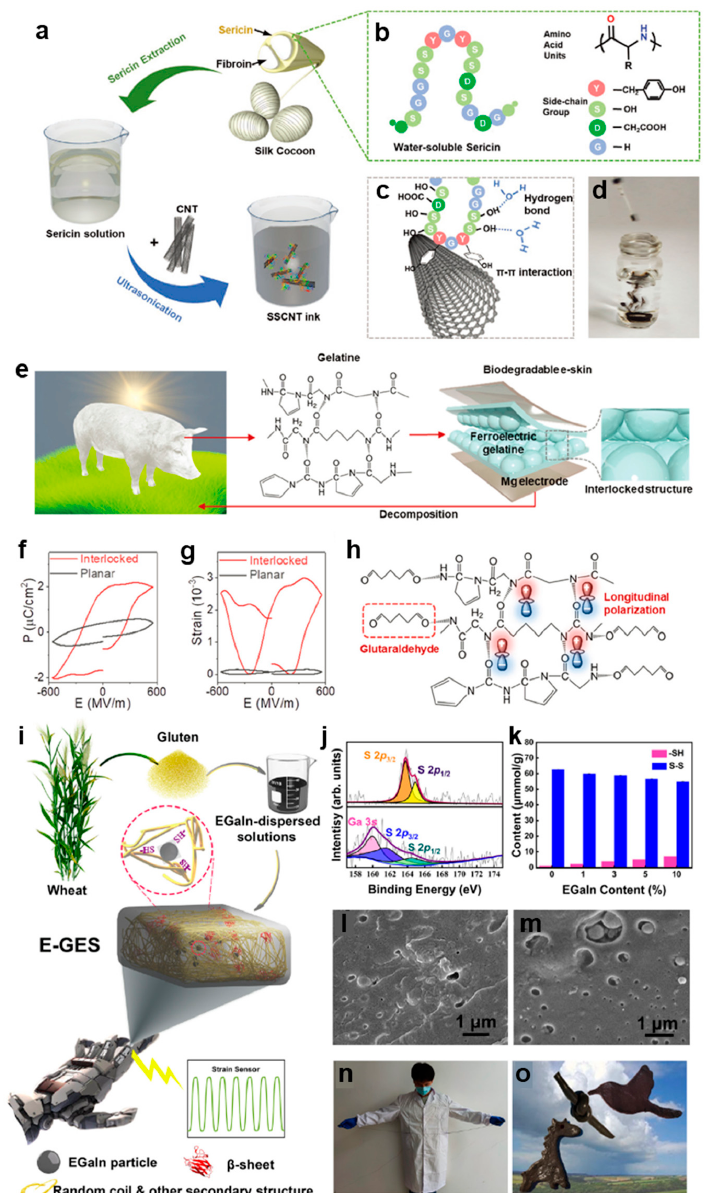
Figure 1. Fabrication processes and characterization of diverse protein-based epidermal electron- ics. ( a ) Schematic for extraction of sericin protein from silk cotton and preparation of SSCNT ink. ( b ) Chemical structure of sericin protein. ( c ) Schematic illustration showing π – π interaction between CNT and sericin, and hydrogen bond between water molecule and sericin. ( d ) Photograph of the SSCNT ink dispersing quickly in water [66]. ( e ) Structure and bio-decomposition of gelatin-based ferroelectric skin. ( f ) P-E hysteresis loop and ( g ) Strain hysteresis loop of interlocked and planar structured gelatin-based epidermal electronics. ( h ) Ferroelectric enhancement mechanism by the